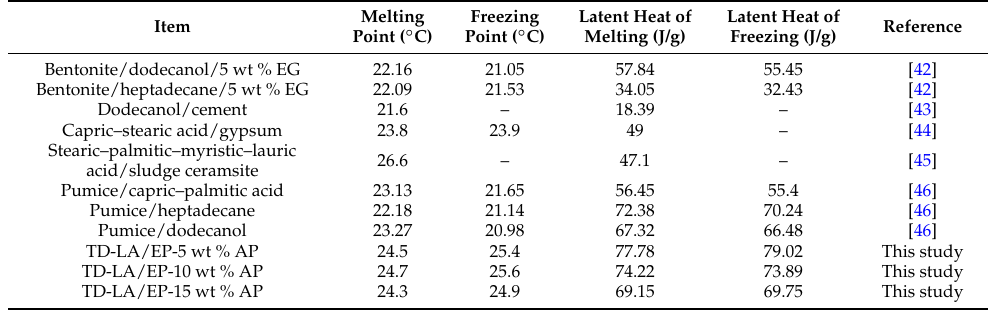
Table 7. Heat transfer coefficients with different AP